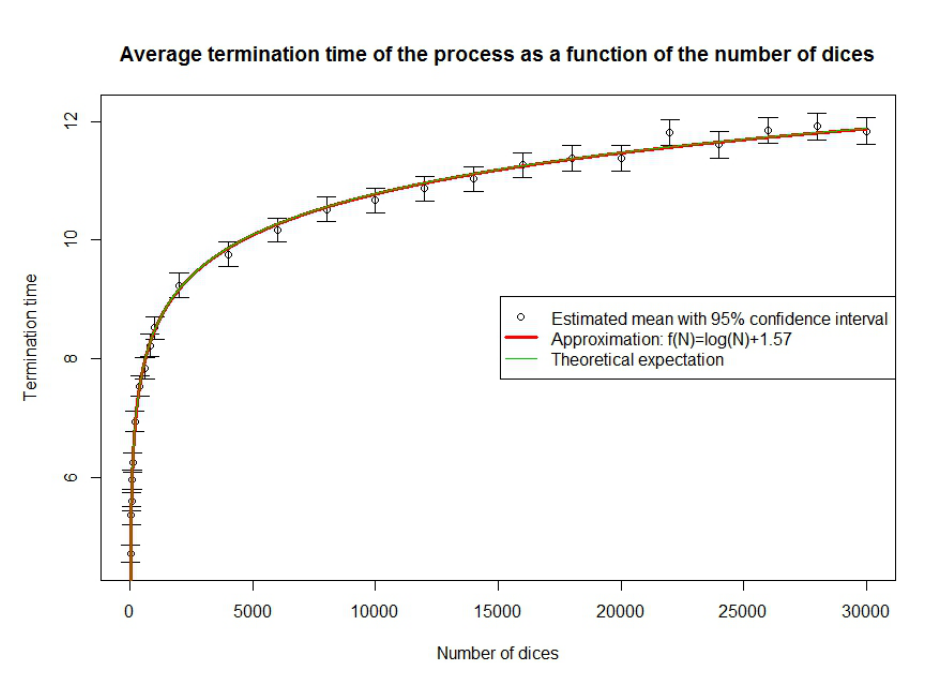
Figure 2. Average run-off time of the process for short size